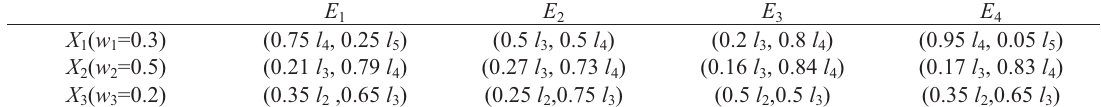
Table 4. The integrated decision matrix